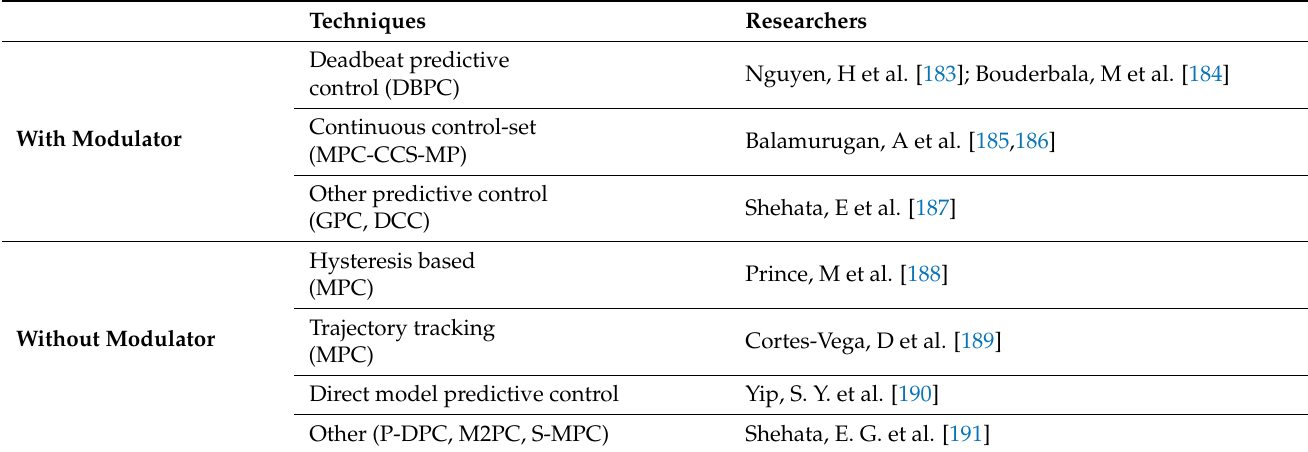
Table 8. Various techniques used for predictive